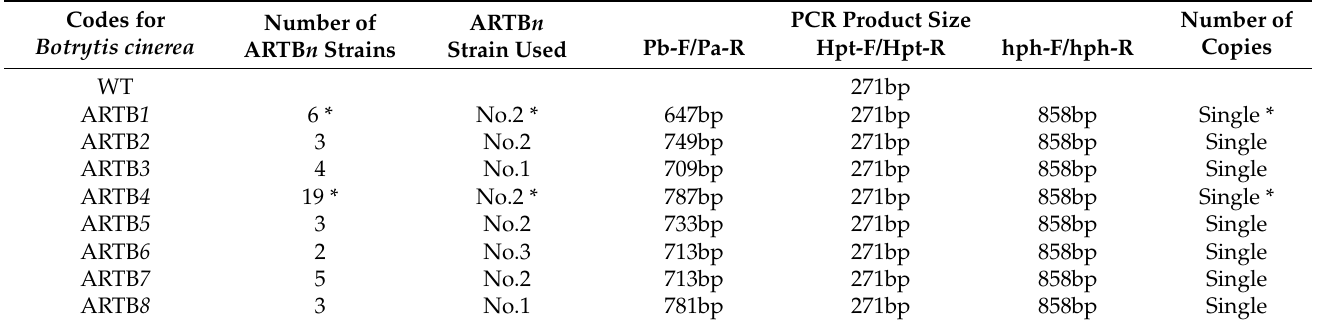
Table 1. Identification of Ab-far-n hpRNA transgenic Botrytis cinerea (ARTBn) used in this study.